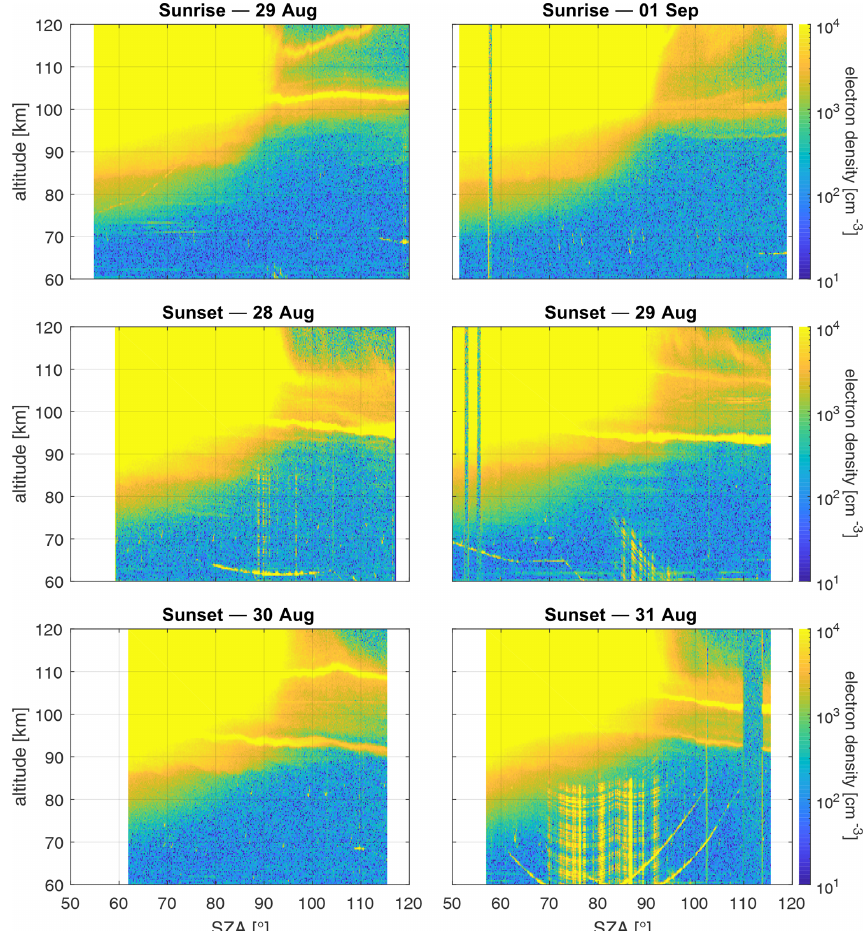
Figure 1. Arecibo radar measurements of the electron density from 28 August until 1 September 2016: four successful measurements during sunset and two during sunrise. The x axis has been set to solar zenith angle (SZA) for better comparability. The maximum value of the colour bar has been intentionally set to 10 4 cm − 3 to highlight low electron density